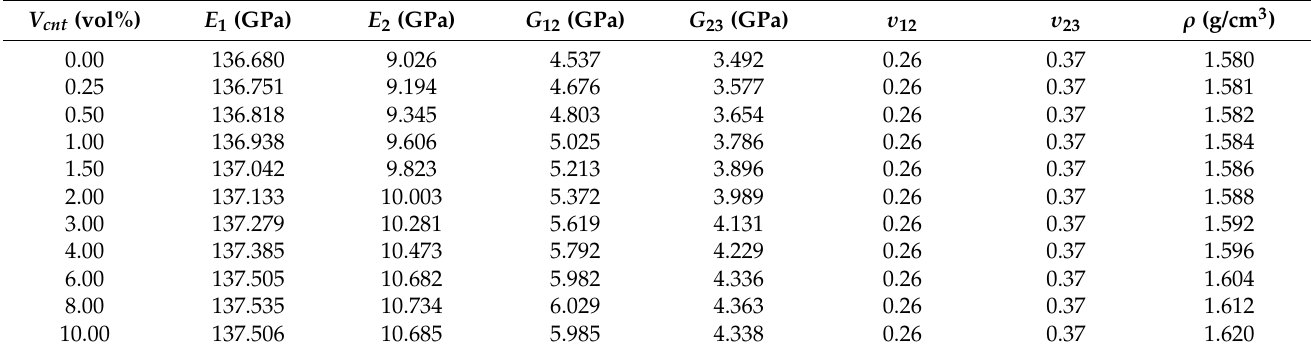
Table 2. Mechanical properties of MWCNT-reinforced nanocomposite